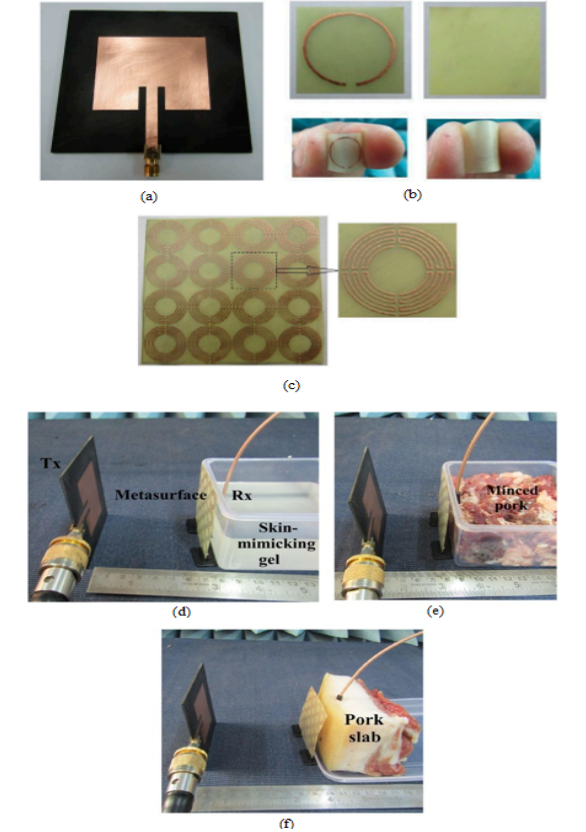
Figure 7. Prototype and measurement setup of implantable WPT system: ( a ) fabricated Tx patch antenna; ( b ) fabricated RX implantable loop antenna; ( c ) metasurface design of 4 × 4 unit cell array; ( d ) testing RX element inside skin-mimicking gel; ( e ) testing RX element inside minced pork; ( f ) testing RX element inside pork slab [175].